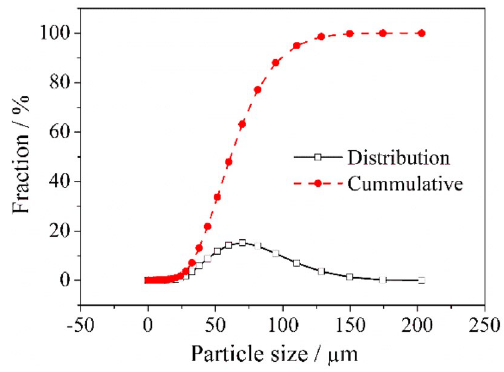
Fig. 4 Cumulative percentage vs particle size for the optimized